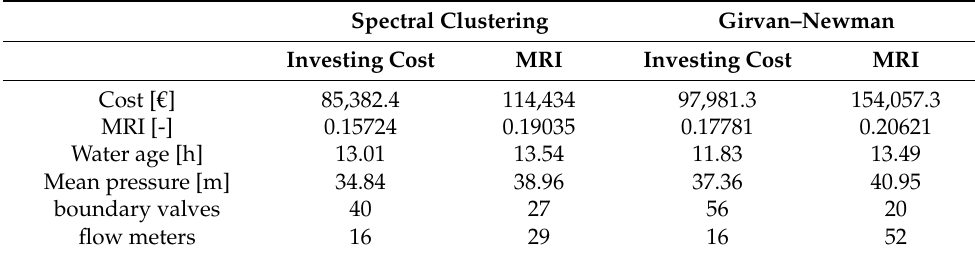
Table 5. Cost, MRI, water age, number of boundary valves, and flow meters for the different clustering algorithms and objective